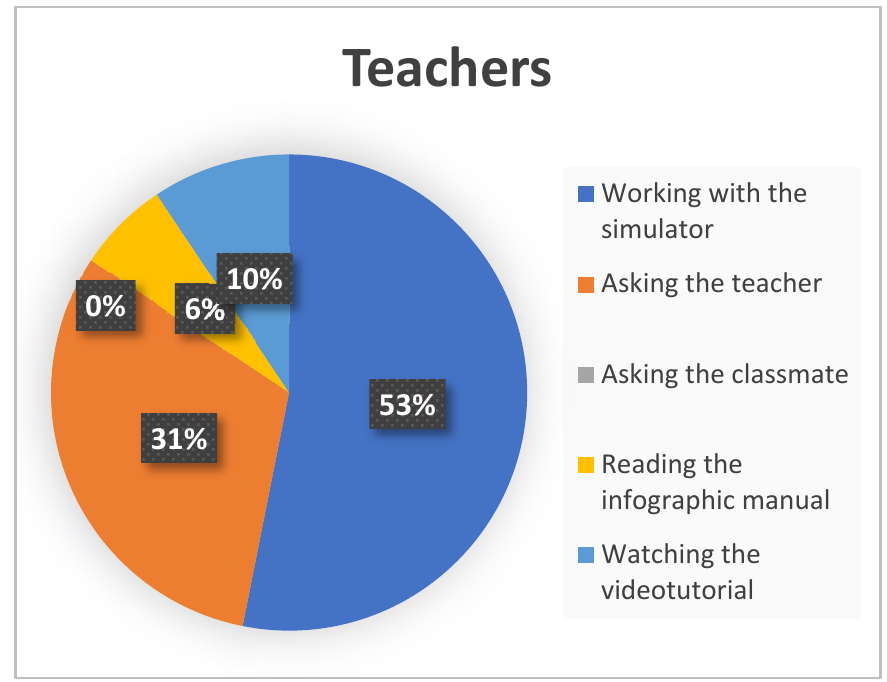
Figure 7. Percentages of the most effective strategies for knowledge/learning of the simulator in the teacher´s sample.